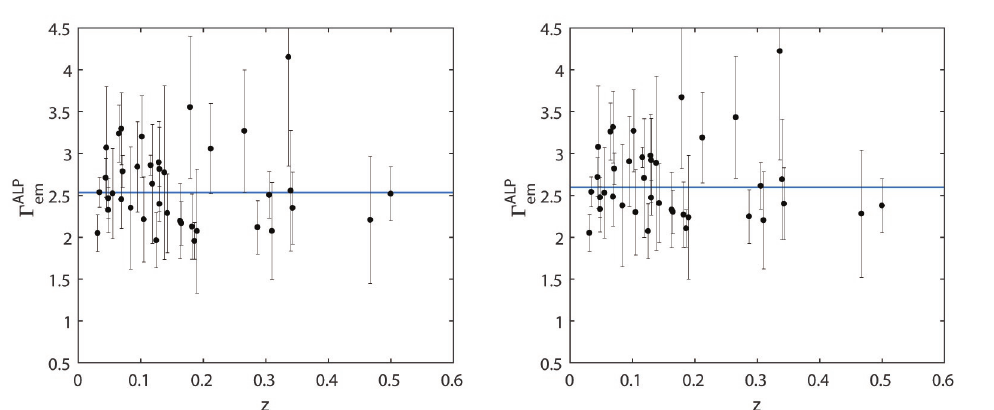
Figure 10. Left panel : the values of Γ ALP em with the corresponding error bars are plotted versus z for all considered blazars in the case L dom = 4Mpc, ξ = 0.5. Superimposed is the horizontal straight = 1.29. Right panel : Same as left panel, but best-fit regression line with Γ ALP em = 2.54 and χ 2 red,ALP corresponding to the case L dom = 10Mpc, ξ = 0.5. Superimposed is the horizontal straight best-fit = 1.25. (Credit regression line with Γ ALP em = 2.60 and χ 2 red,ALP